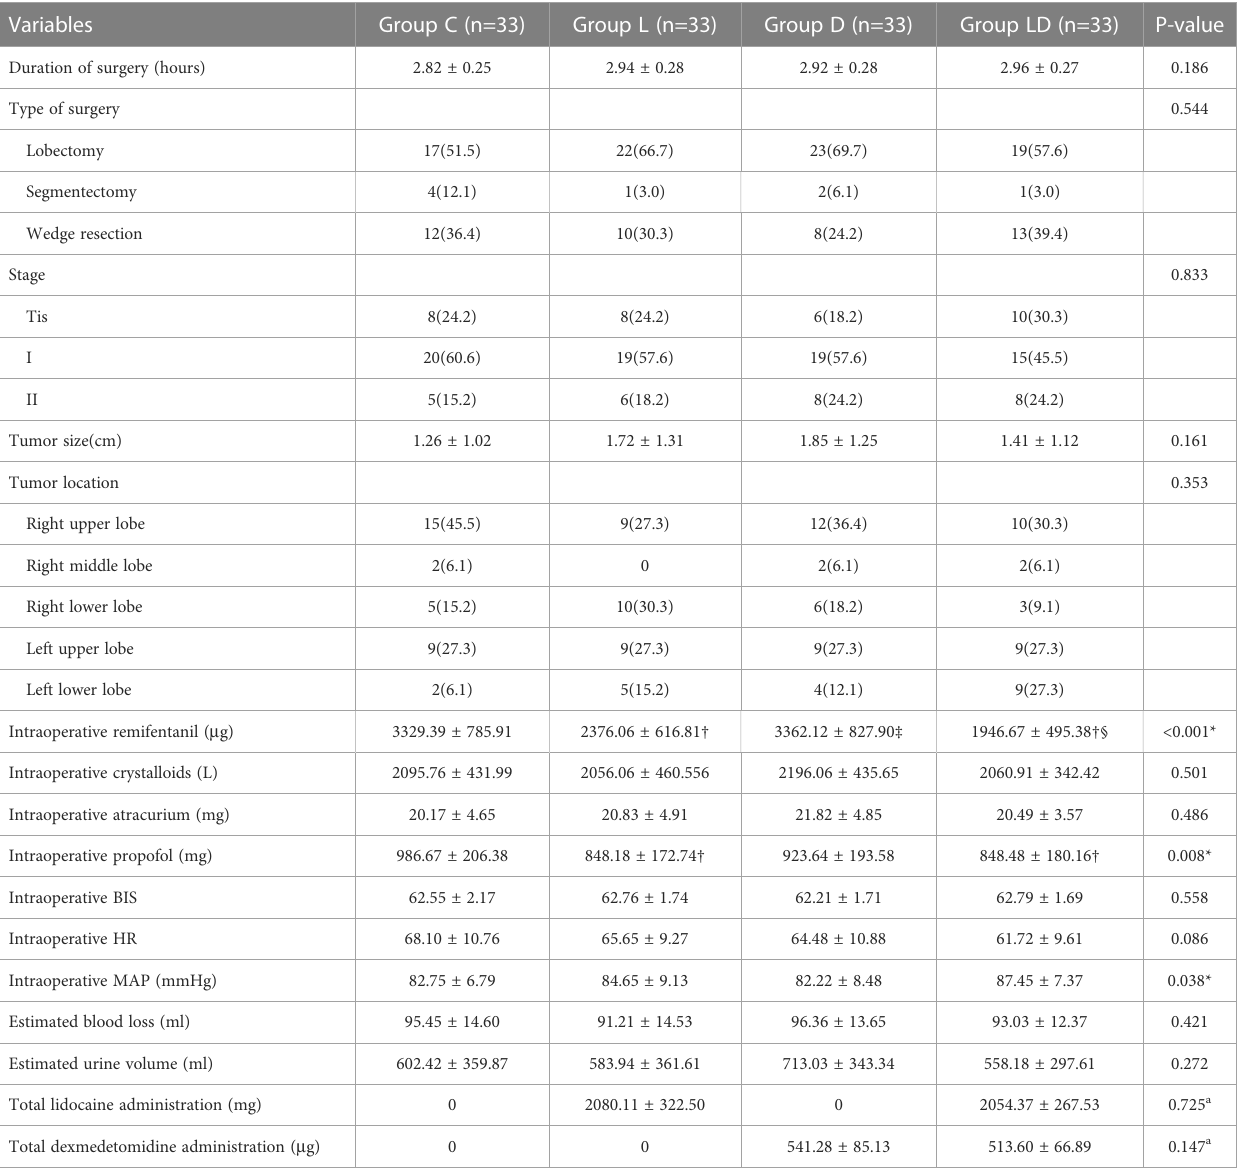
TABLE 2 Surgical and intraoperative